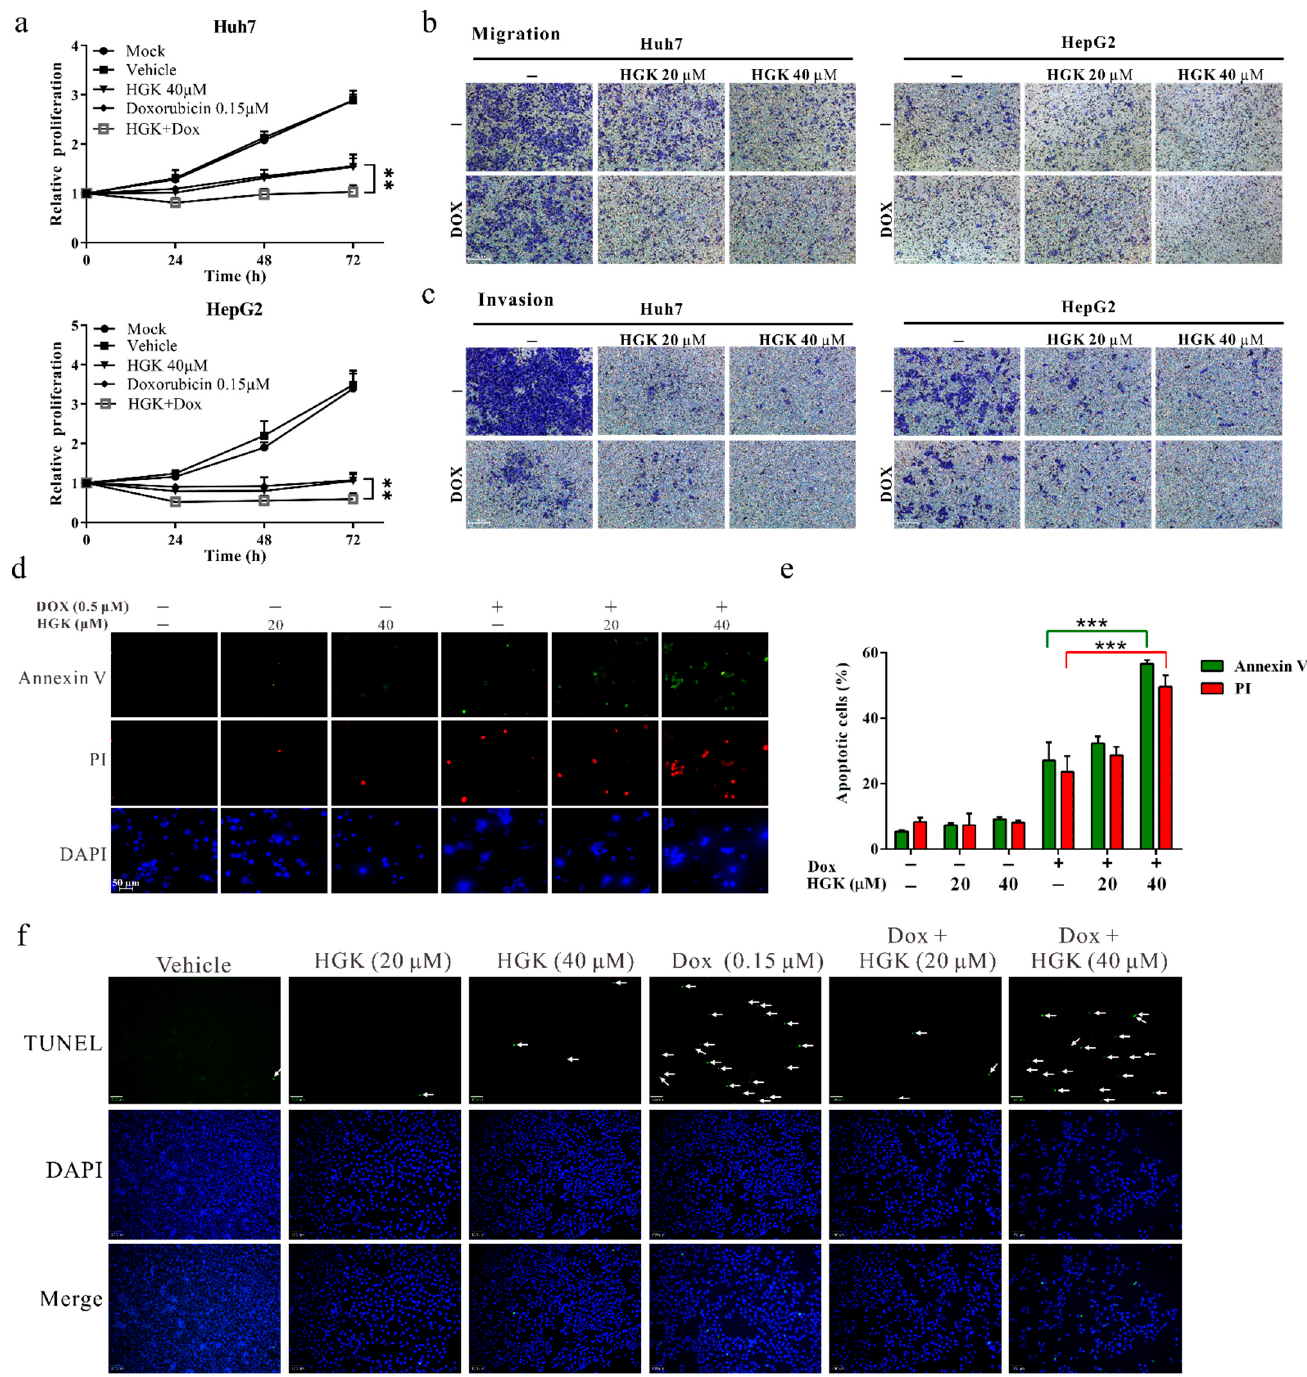
Figure 6. Hydroxygenkwanin (HGK) increases the sensitivity of hepatocellular carcinoma cell lines to doxorubicin. ( a – c ) The effect of HGK combined with doxorubicin on the proliferation, migration, and invasion of Huh7 and HepG2 cell lines. p < 0.01 (**), p < 0.001 (***). ( d – f ) The effect of HGK combined with doxorubicin on apoptosis in Huh7 cells was analyzed using Annexin V/PI staining and terminal deoxynucleotidyl transferase dUTP nick-end labeling (TUNEL) assay. Green punctate staining represents TUNEL-positive cells (white arrow). All experiments were performed in triplicates.